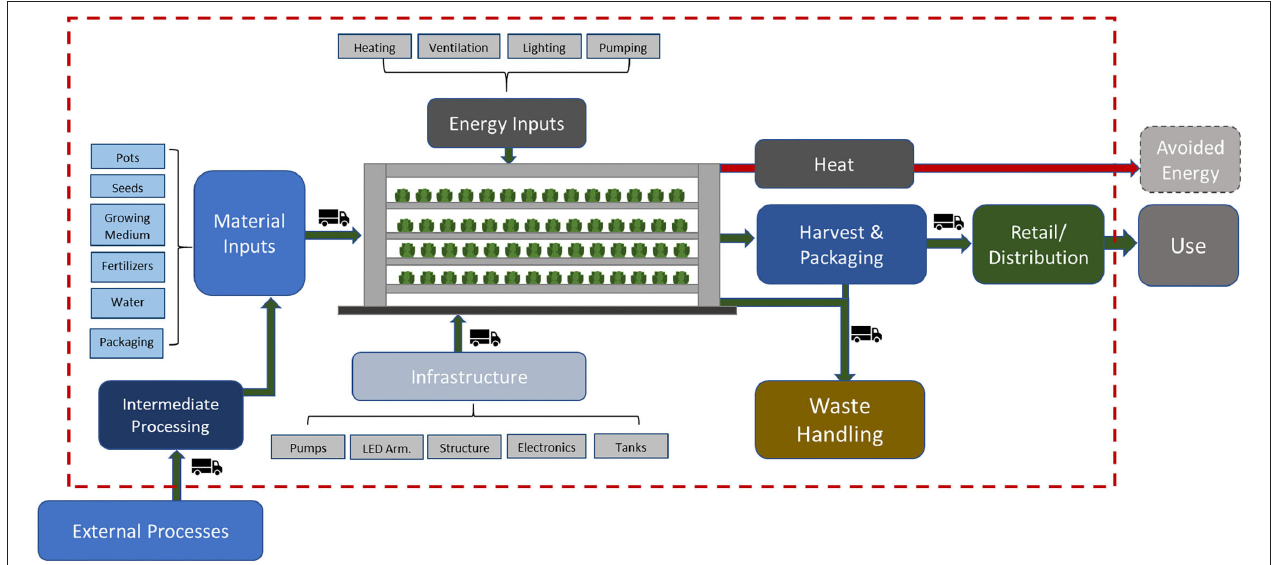
FIGURE 1 | System boundaries of the study, including all material and energy inputs, and avoided processes from by-products of the vertical